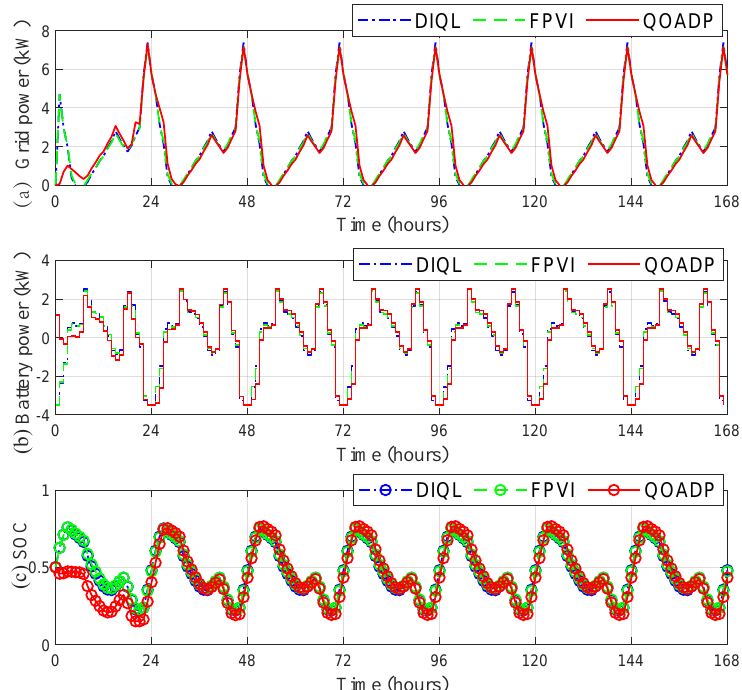
Figure 6. System state and control under periodic assumption: ( a ) Grid power; ( b ) Battery power; ( c ) SOC.